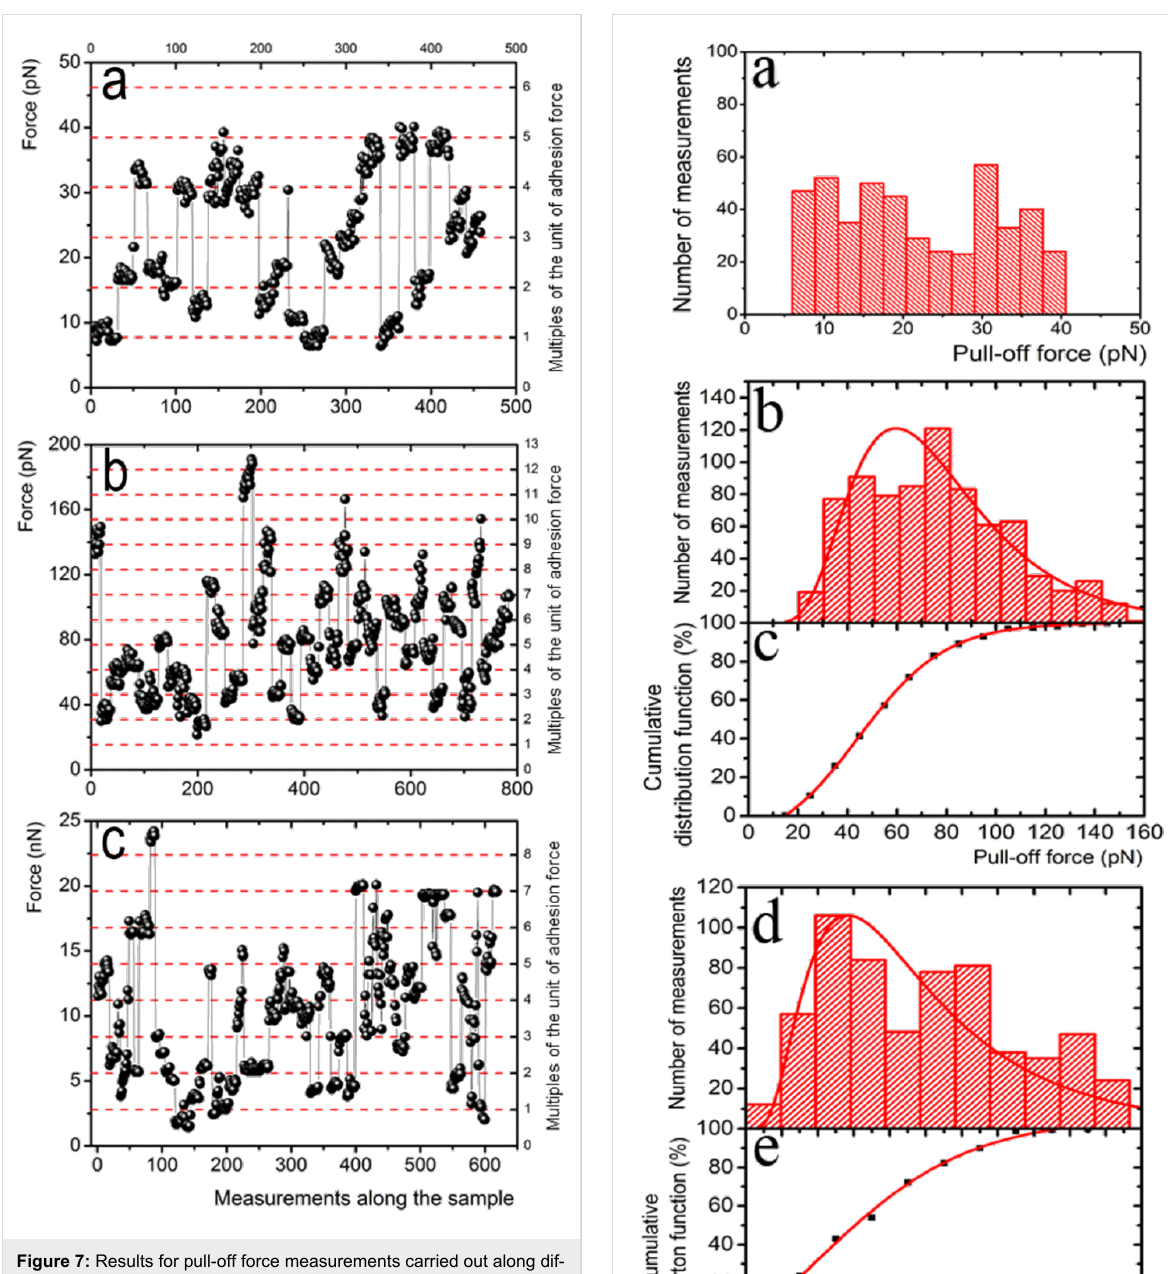
Figure 7: Results for pull-off force measurements carried out along dif- ferent surfaces. The pull-off force between the array of sharp silicon peaks and both (a) a hollow glass sphere, and (b) a mercury drop. (c) The pull-off force between the multi-scaled rough diamond surface and a mercury drop. Measurements were carried out on 26, 44, and 51 different areas of the surfaces, respectively. Right axes and red dashed lines are the same pull-off forces plotted on the left axes, but divided by the unit force of adhesion that is different for each system, as explained in the text. Figure 8: Statistics of the whole set of pull-off force measurements.